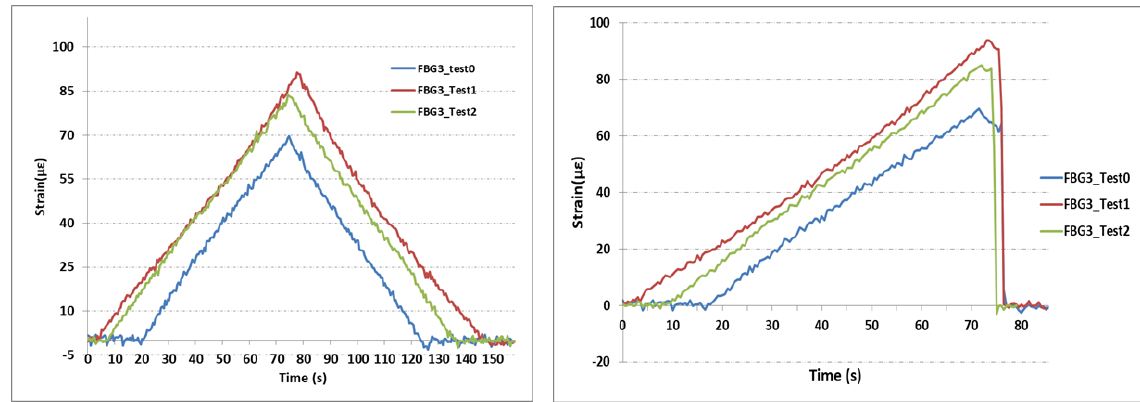
Figure 13. Strain measurements from the FBG3 sensor. Left : Strain measurements from the test profile of gradual changes; Right : Strain measurements from the test profile of sudden changes.